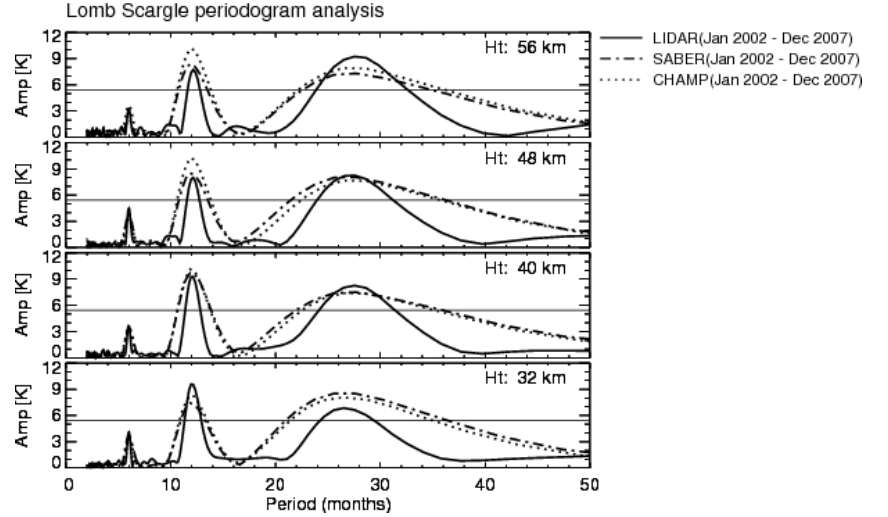
Fig. 10. The spectral amplitudes of the temperature data obtained from LIDAR, SABER and GPS (CHAMP+COSMIC) for the height levels Figure 10: The spectral amplitudes of the temperature data obtained from LIDAR, SABER 2 at 32km, 40km, 48km and 56km, based on the same datasets used for Figs. 8 and and GPS (CHAMP+COSMIC) for the height levels at 32 km, 40 km, 48 km and 56 km, 3 based on the same datasets used for Figs. 8 and 9. 4